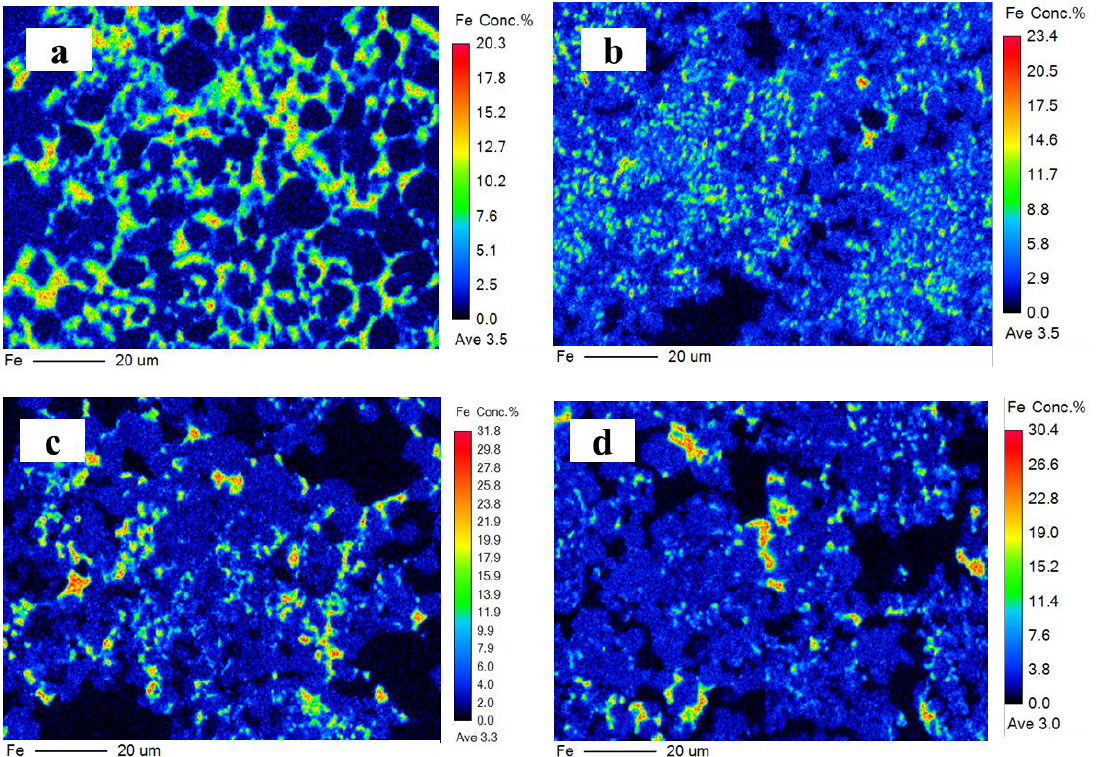
Figure 7. Iron distribution on polished surface of clinker S00 ( a ), S50 ( b ), S80 ( c ), and S100 ( d ). Table 6. Chemical composition of ferrite phase of samples S00, S50, S80, and S100.